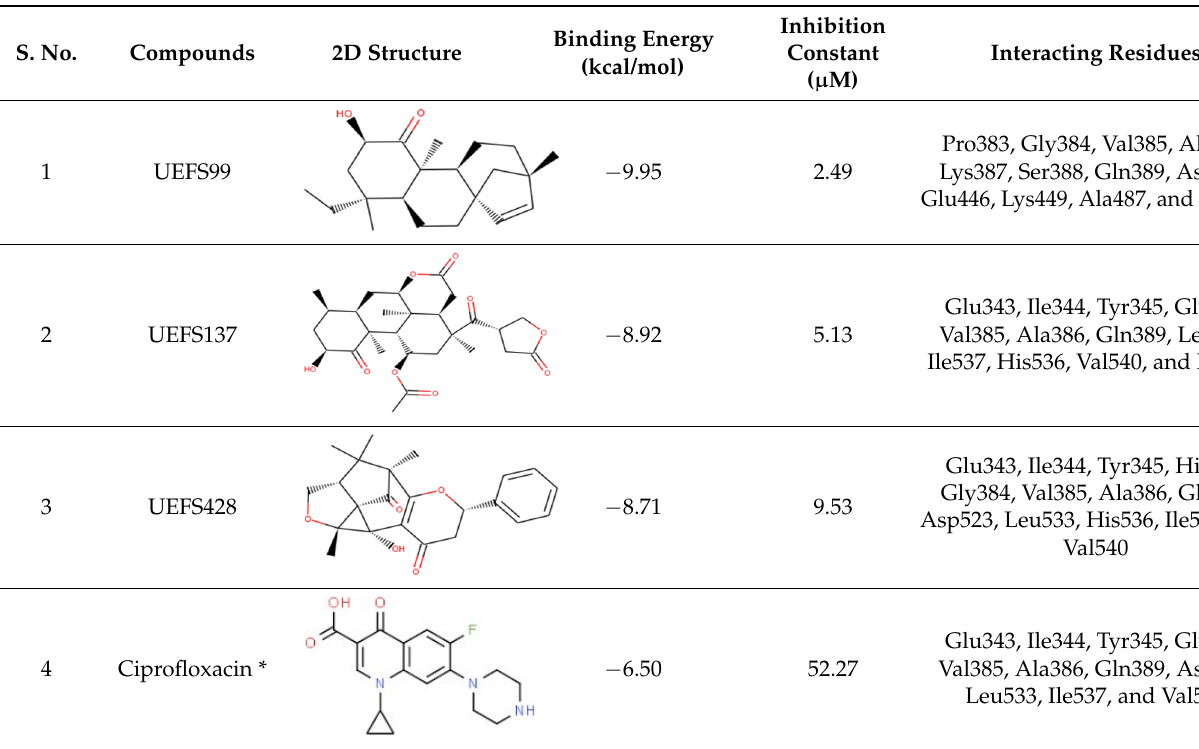
Figure 3. MCM7 protein-interacting residues with UEFS428. Different color code represents the residual interaction types.